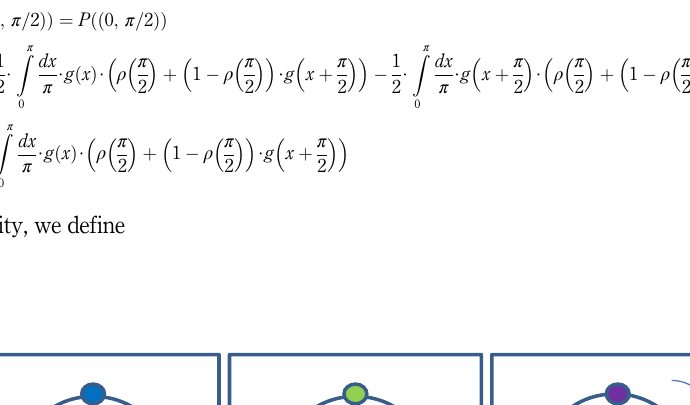
Figure 15. Symmetries of f 2 $ μ i j i ¼ 0 ; ... ; 3 g ¼ f 0 ; π = 2 ; π ; 3 $ π = 2